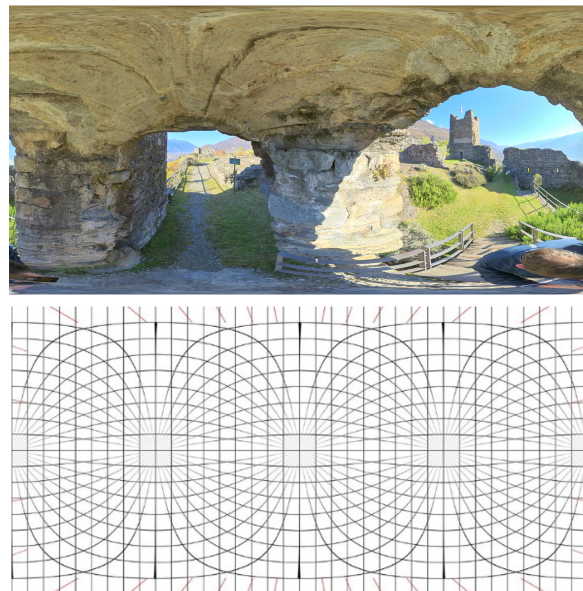
Figure 3: 360° image visualized as equirectangular projection (top), and the deformed grid pattern of horizontal and vertical lines (bottom).